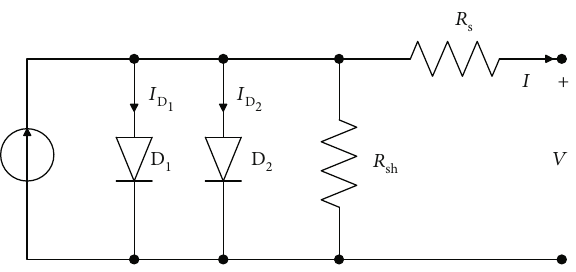
Figure 1: Two-diode circuit model for the PV